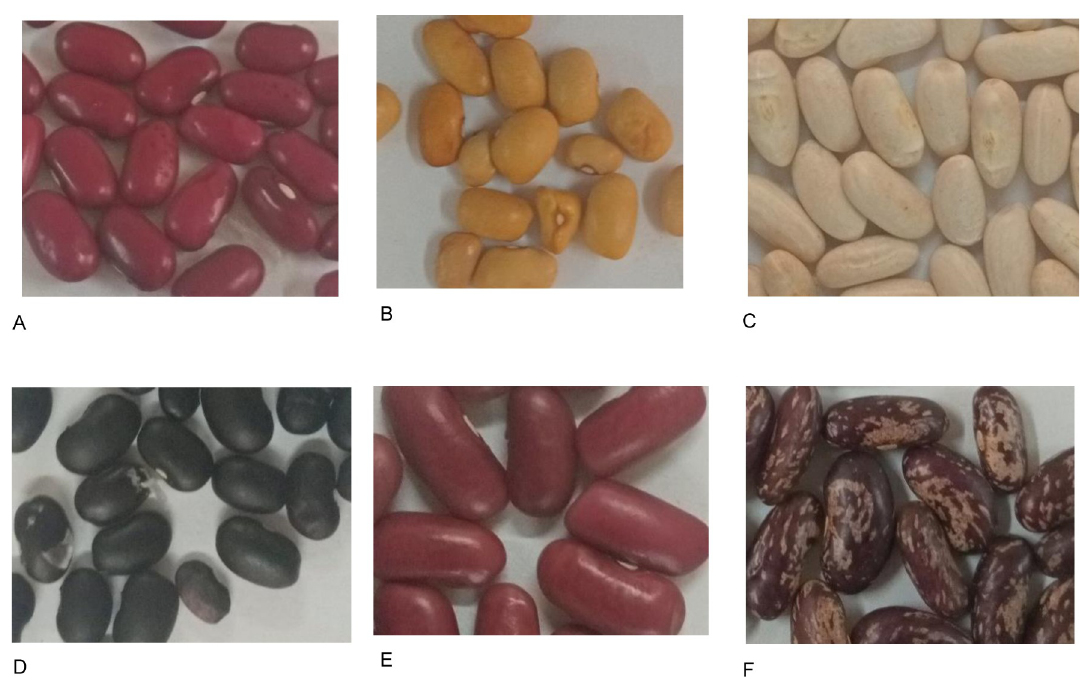
Fig 2. Variation in seed colour, size and shape among assessed bean genotypes. Note: A–Red, small, seed, kidney bean (SER265), B– Yellow, small seed,round bean, (MW3933) C–White, large seed, kidney bean (SAA20), D–Black,smallseed, kidney bean (genotype SEN125), E–Dark red, large seed, kidney bean (DRK57), F–Red mottled, large seed, kidney bean (NUA59). https://doi.org/10.1371/journal.pone.0243238.g002 The bi-plot clustered all genotypes into four groups (Fig 3). Genotypes in quadrant I were high yielding, followed by those in quadrant II. The low yielding genotypes were clustered in quadrant IV. Genotypes that were clustered in quadrant I include: angular leaf spot resistant (ALS) accessions such as A344 (E89), DRK57 (E52), NUA35 (E63), NUA59 (E85) and UBR (25)9 (E58). These genotypes are late maturing, high yielding and resistant to multiple stresses. MW3945 (E91), MW3955 (E11) and MW3933 (E50) were landraces that were grouped in quadrant I. VTTT924/10-4 (E80), a released large red kidney bean cultivar resistant to angular leaf spot (ALS) was found in quadrant II with landraces such as MW3924 (E81), MW3969 (E10) and MW3959 (E47). Quadrant III had two genotypes: Nyambitira (E3), a dark red